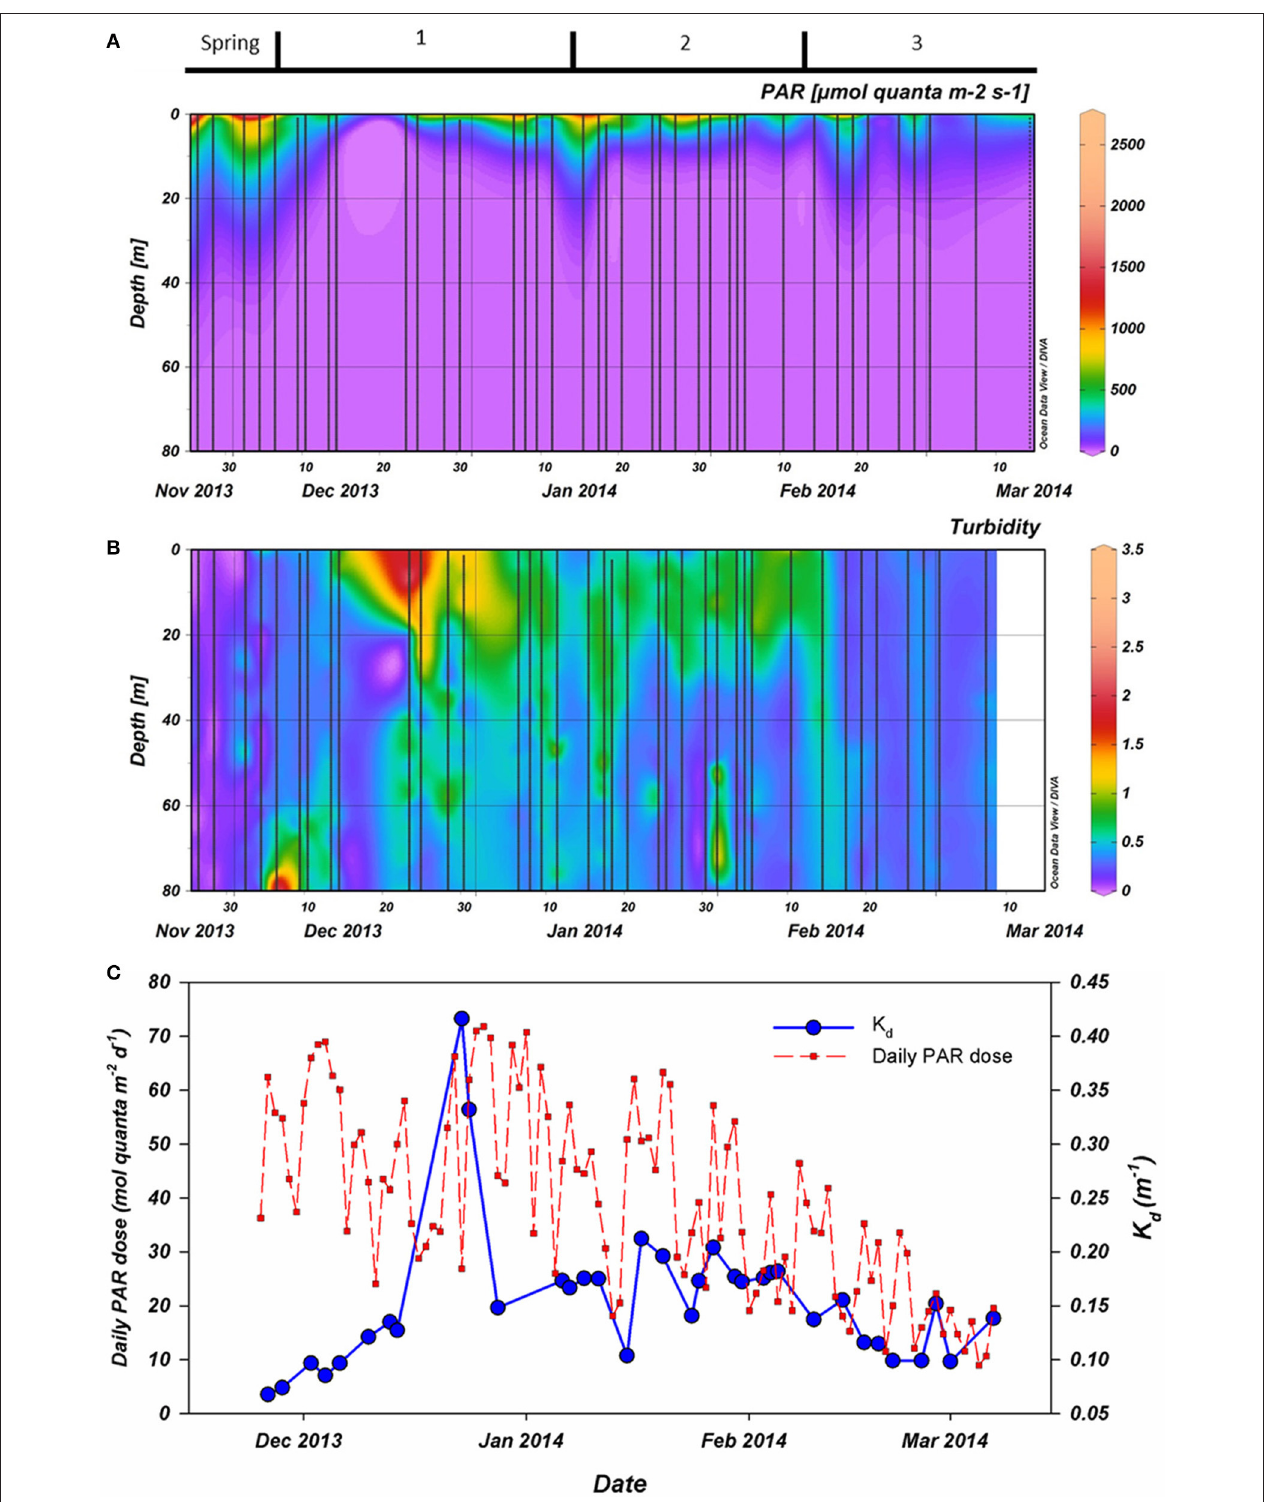
FIGURE 2 | (A) : Photosynthetically active radiation (PAR) as measured during CTD casts (vertical casts). (B) : Turbidity as also measured during the CTD casts. (C) : First, the extinction coefficient (K d in blue) as calculated using the PAR data collected by CTD. Also, the daily irradiance dose for PAR (red) integrated from continuous measurement at Rothera station. All data were collected during the 2013–2014 season. Period 1 starts on December 6th, period 2 on January 15th and period 3 on February 10th.